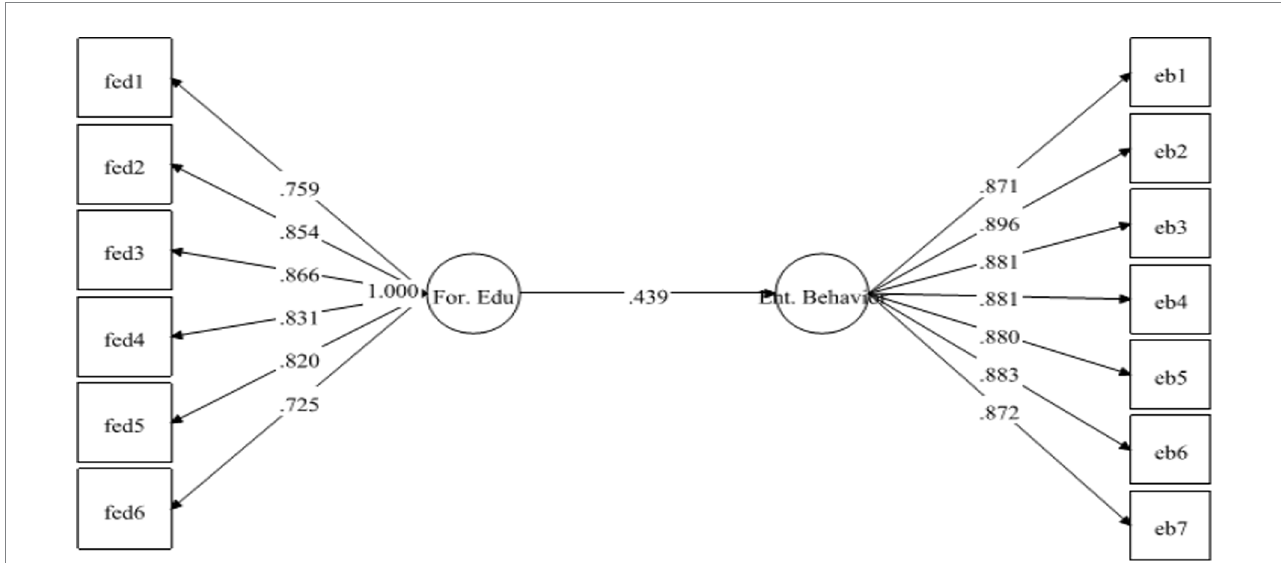
FIGURE 1 Direct relationship between formal education (For. Edu) and entrepreneurial behavior (Ent. Behavior).